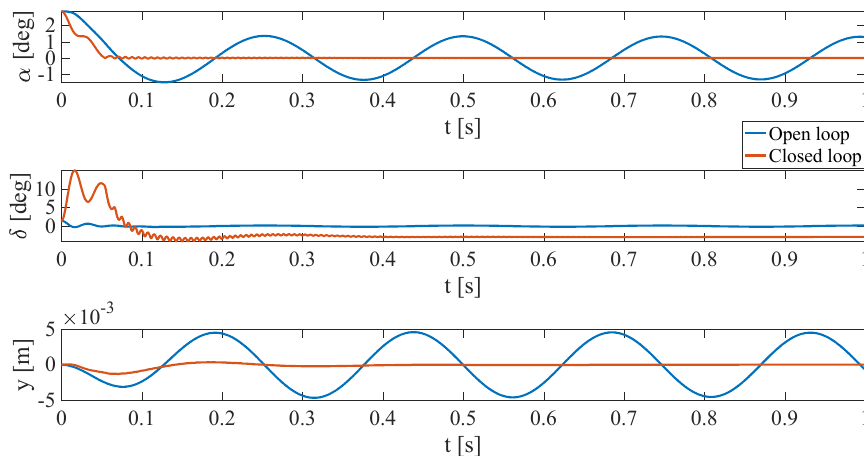
Figure 14. Pole migration of the gain-scheduled PID.